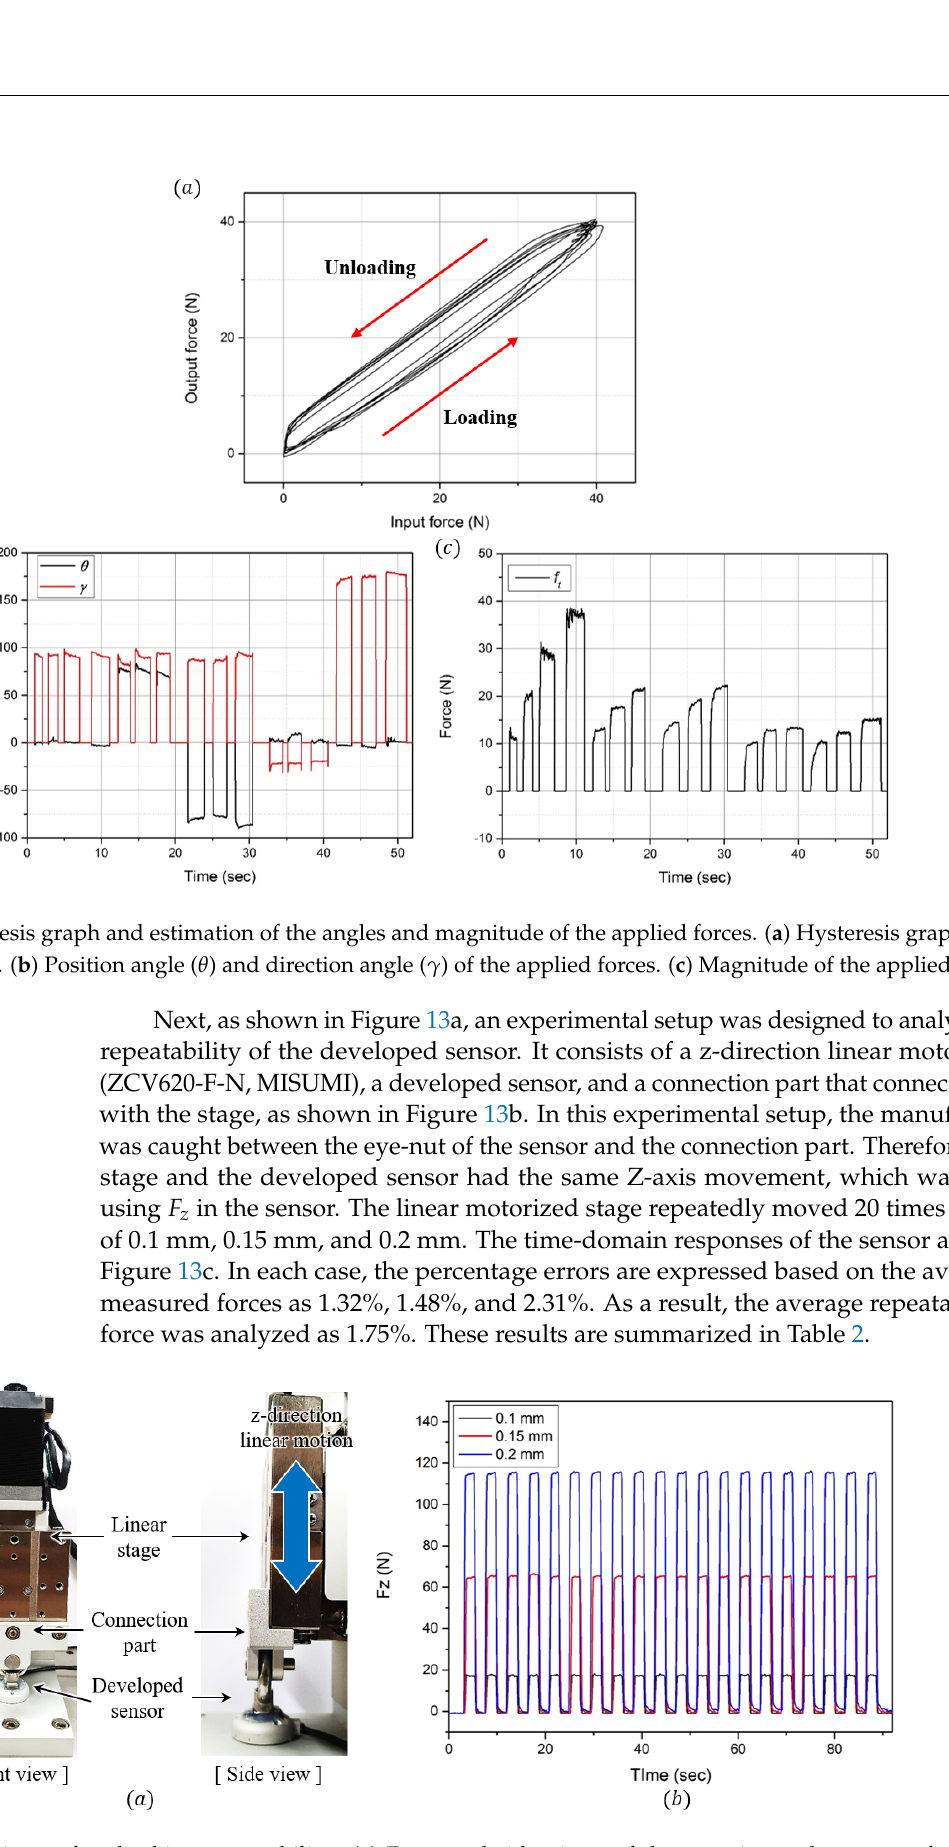
Figure 13. Experiment for checking repeatability. ( a ) Front and side views of the experimental setup configuration. ( b ) Results of the three repeatability